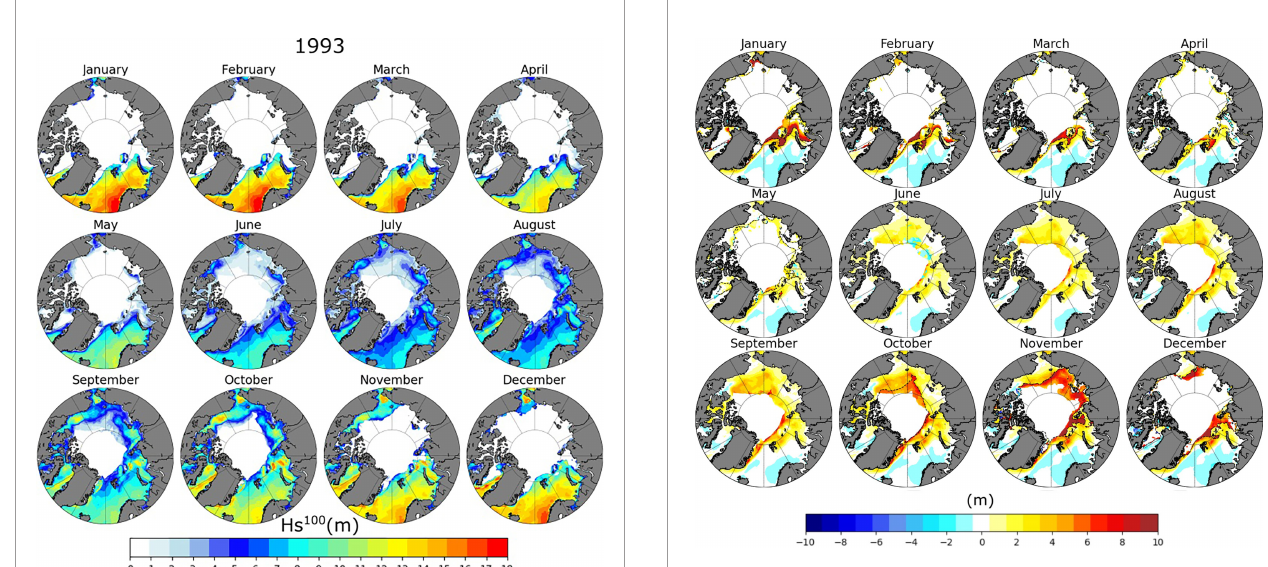
FIGURE 11 | H 100 s (m) for 1993 obtained with a POT analysis and a GPD distribution for the TS-EVA seasonal approach. Data obtained from the 28- year wave hindcast with ERA5 wind forcing.